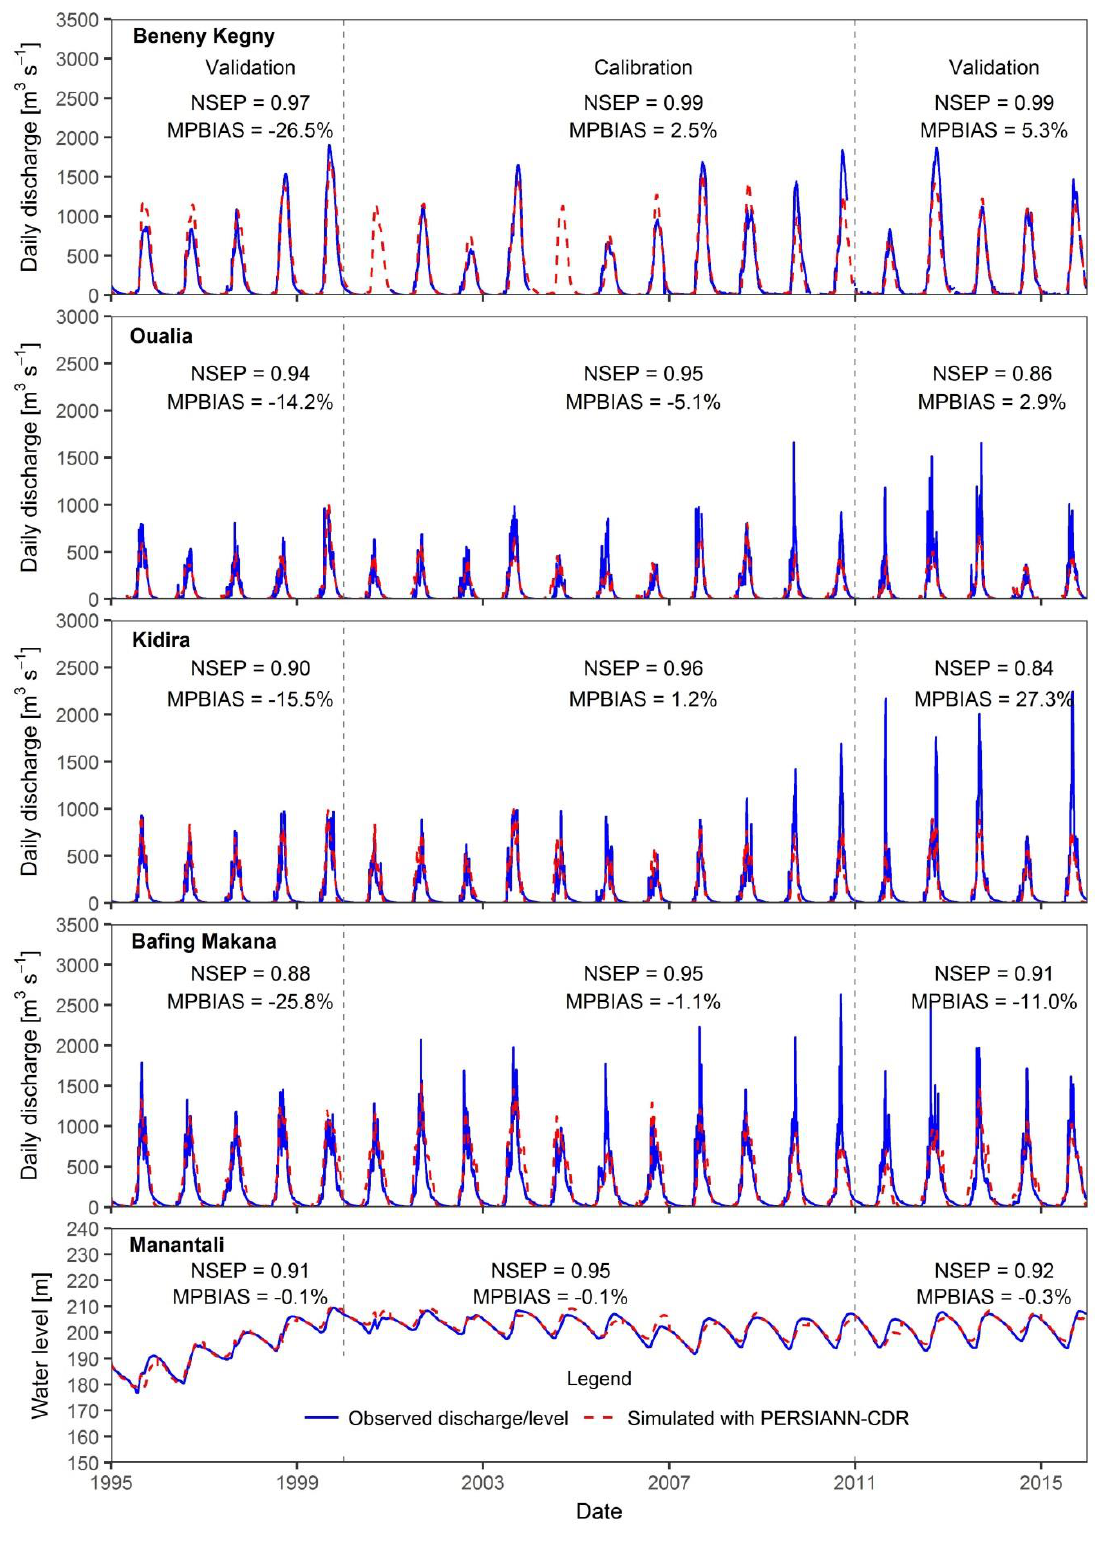
Figure 7. Observed and simulated discharges and water level using bias-corrected PERSIANN-CDR.